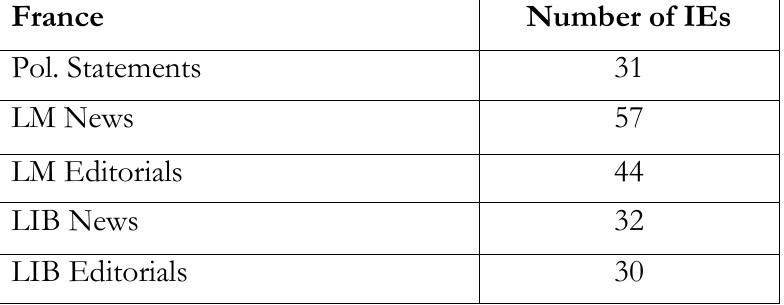
Table 2. Framing samples in the French political statements and media coverage